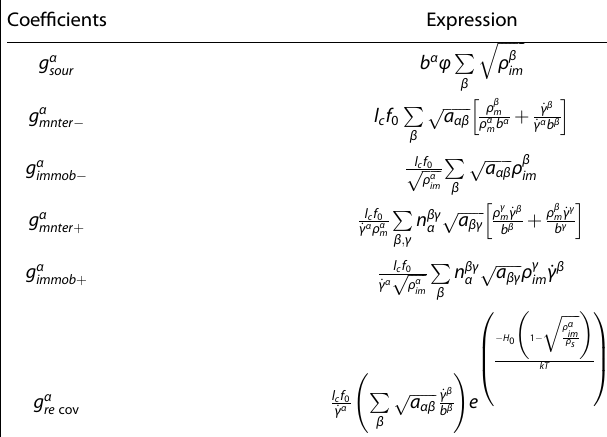
Table 1. Coef fi cients for dislocation-density equations (Eqs. 1, 2). Coef fi